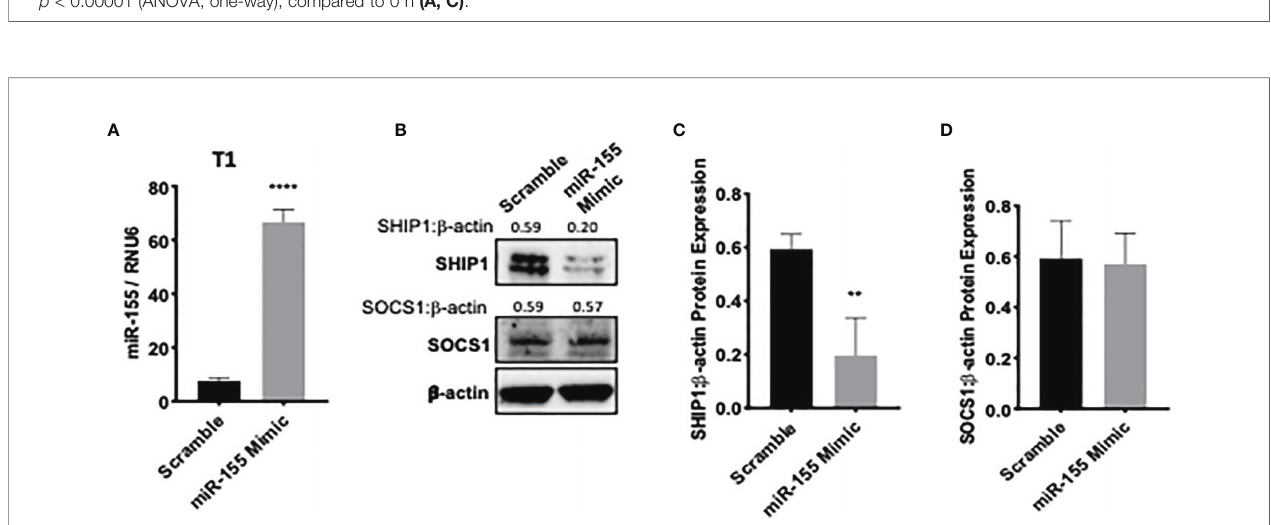
FIGURE 5 | Time kinetics shows the increase of miR-155 and the decrease of its targets suppressor of cytokine signaling 1 (SOCS1) and SH-2 containing inositol 5 ’ -polyphosphatase 1 (SHIP1) in T1 cells following bortezomib treatment. Human lymphoblast T1 cells were treated in vitro with 10 nM bortezomib for 2, 4, 6, 9, 12, 18, and 24 h. The cells were collected at each time point and analyzed for miR-155 expression by RT-PCR and for SOCS1 and SHIP1 protein levels by Western blotting. The expression of miR-155 (A) and SOCS1 and SHIP1 protein levels (B) are shown by function of time in T1 cells upon 10 nM bortezomib treatment. Numbers above the bands are the indicated ratios of the densitometry values. (C) Bar graphs depict SHIP1: b -actin ratios for fold changes in SHIP1 protein as calculated from the densitometry values. Data are presented as mean values ± SD from four independent experiments with triplicates; * p < 0.0072, ** p < 0.0001,